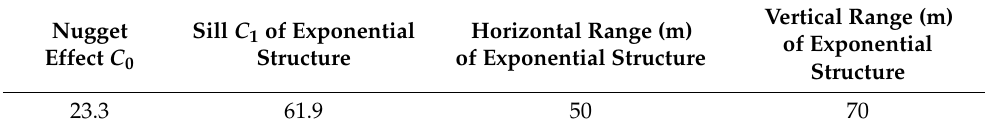
Table 4. Parameters of fitted univariate exponential model